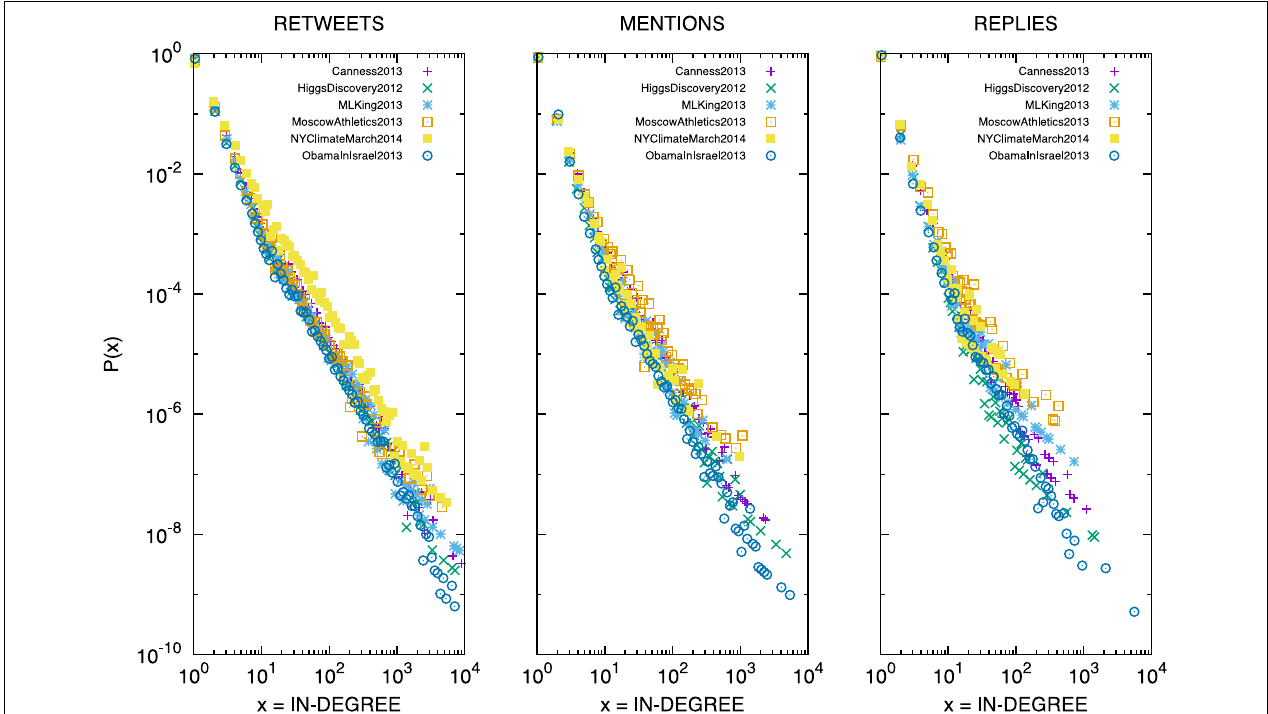
FIGURE 5 | Distribution of the in-degree for each event considered in this study (encoded by points with different shape and color) and each layer: retweets (left), mentions (center), and replies (right).